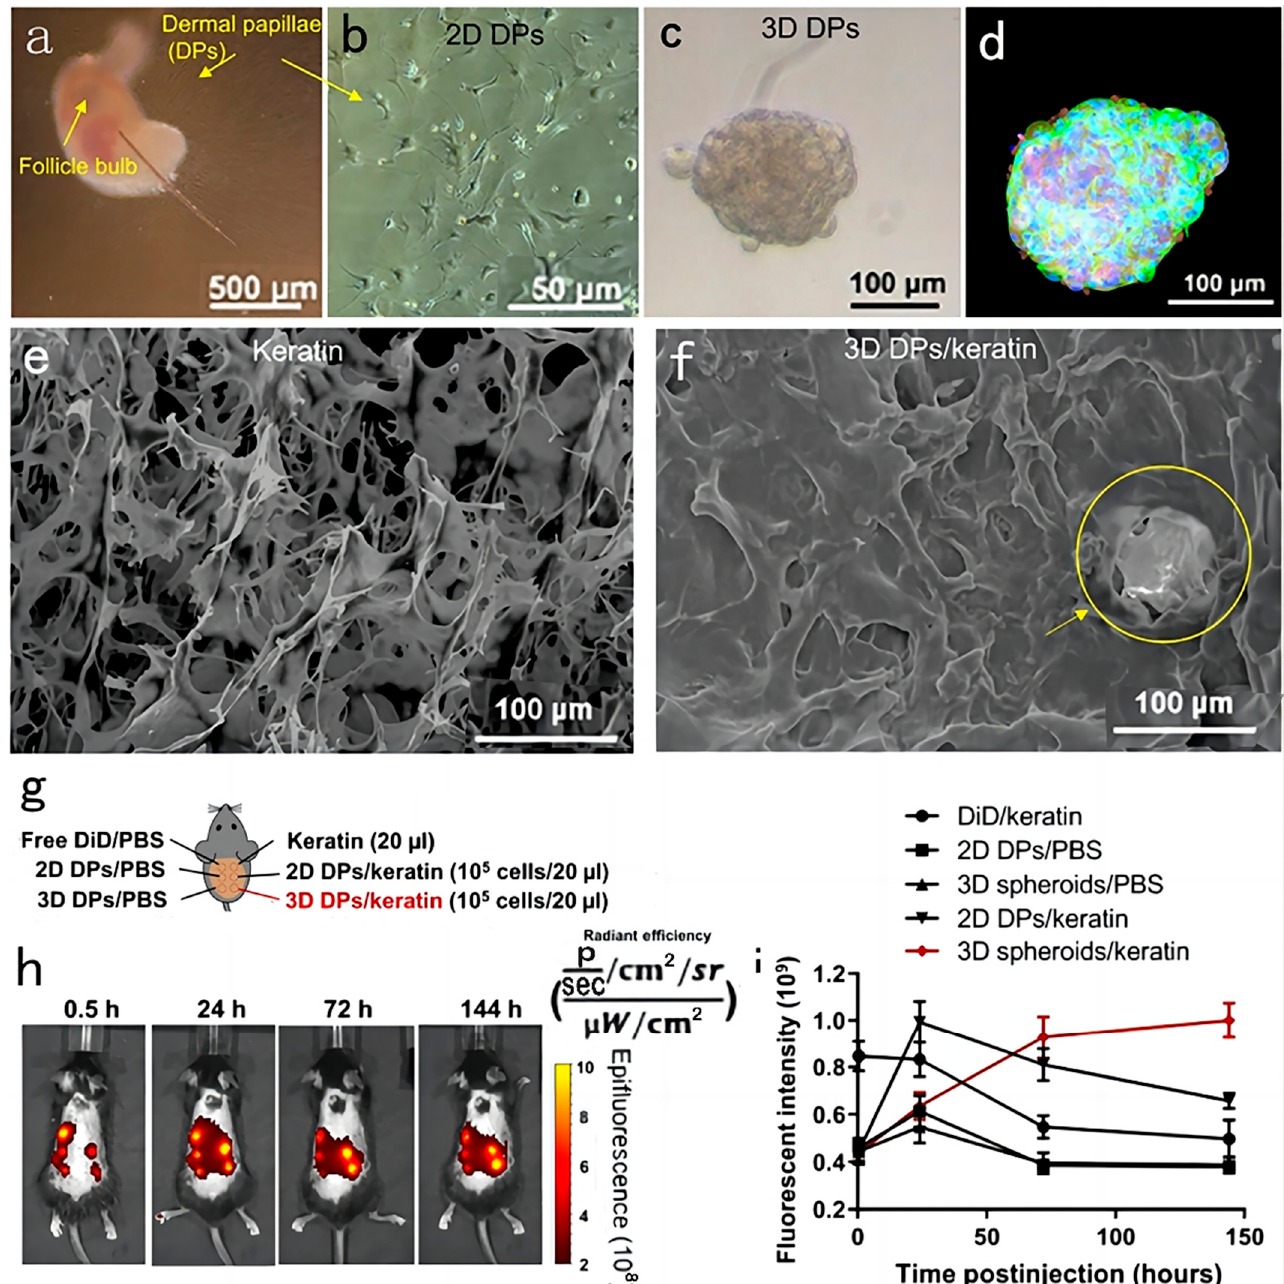
Figure 8. Preparation and characterization of 3D DP spheroids. ( a ) Isolation of mouse DP cells from vibrissae. ( b ) Conventional culture enables the growth of 2D DP cells. ( c ) Growth of DP spheroids in ultralow cell culture flasks. Scale bar, 100 µ m. ( d ) Double staining for CD133 (green) and β -catenin (red) in spheroids. ( e , f ) Scanning electron microscopy (SEM) images of keratin ( e ) and 3D spheroid-loaded keratin. ( f ) One obvious spheroid is highlighted in yellow. ( g ) Schematic illustrating the injection sites on the back of a mouse for the cell retention study. ( h ) The mouse was shaved and received injections of di ff erent formulations on the dorsal skin, as illustrated in ( g ). Cells were labeled with DiD and then resuspended in PBS or keratin for intradermal injection. In vivo imaging system (IVIS) images were taken at di ff erent time points. ( i ) Quanti fi cation of IVIS images [23]. Cop-